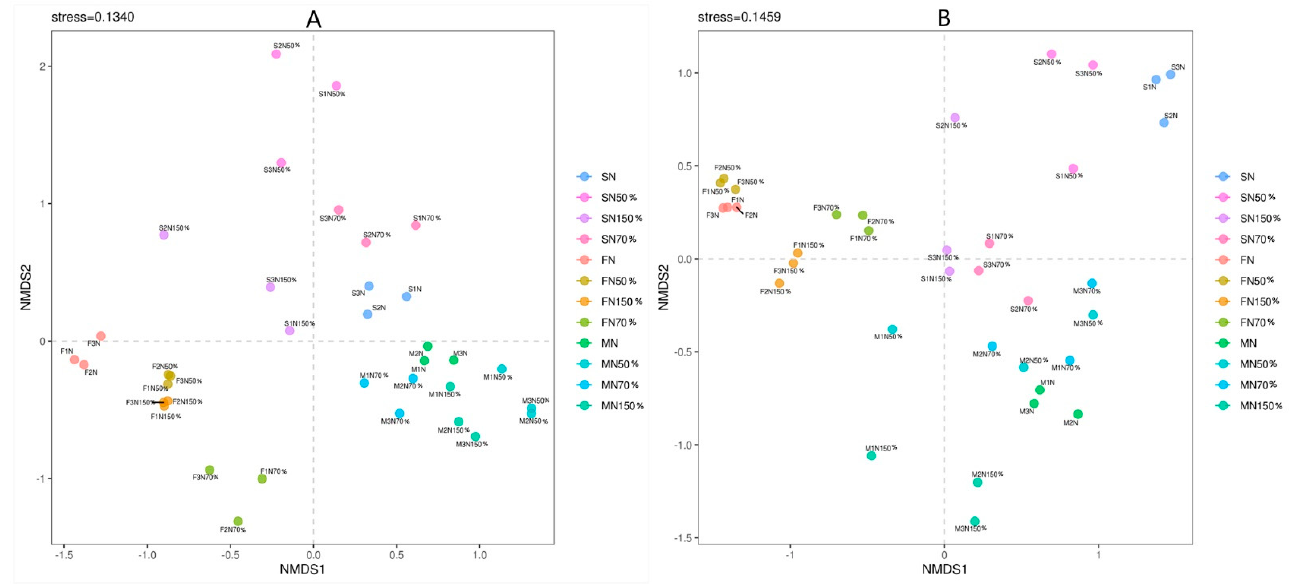
Figure 6. NMDS analysis of all samples. ( A ) Bacteria; ( B ) Fungi.